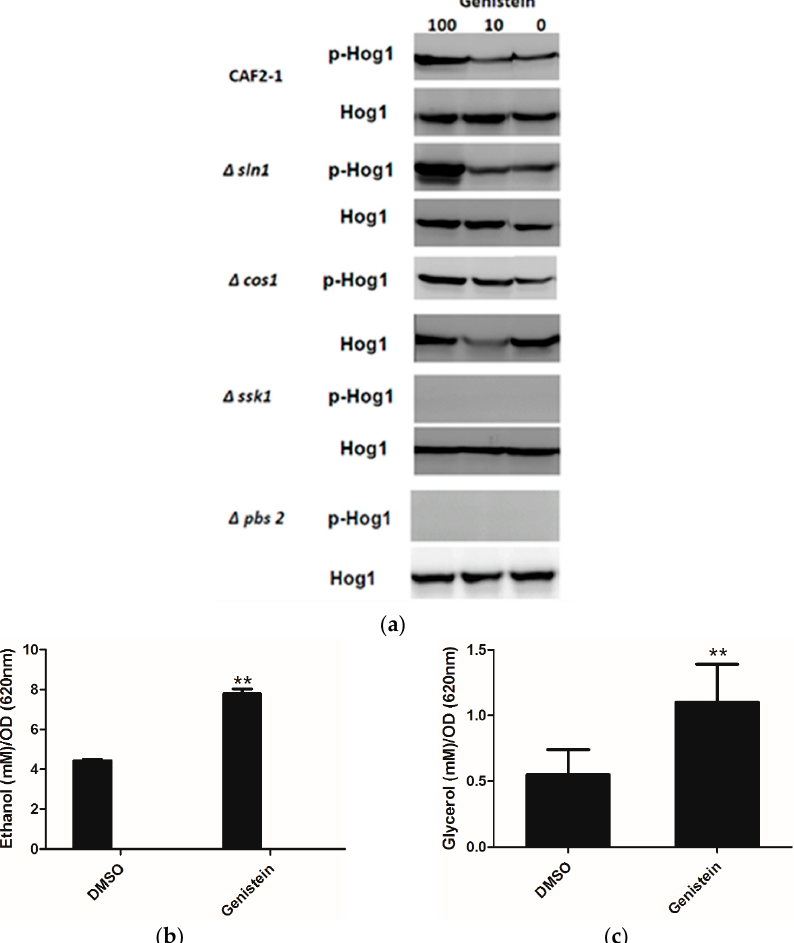
Figure 2. ( a ) Phosphorylation of Hog1p of C. albicans strains after treatment with genistein and solvent for 15min. Hog1p was detected by Hog1 (y-215) sc 9079 rabbit polyclonal IgG and phosphorylated Hog1p (Hog1-P) by Phospho-p38 MAPK (Thr180/182) 3D7 rabbit mAb at a site corresponding to 50 kDa; ( b , c ). Effect of genistein on glycerol and ethanol production in C. albicans . ** p < 0.01 (comparison with DMSO control). with DMSO